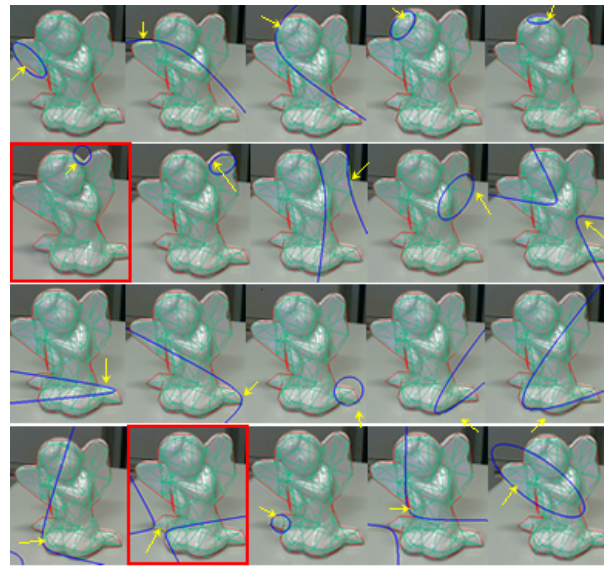
Fig. 6. Conics Tracking: conic curves (in blue) on the patches that belong to the object contour. The images highlighted by the red square show patches with a bad conic fitting for the current